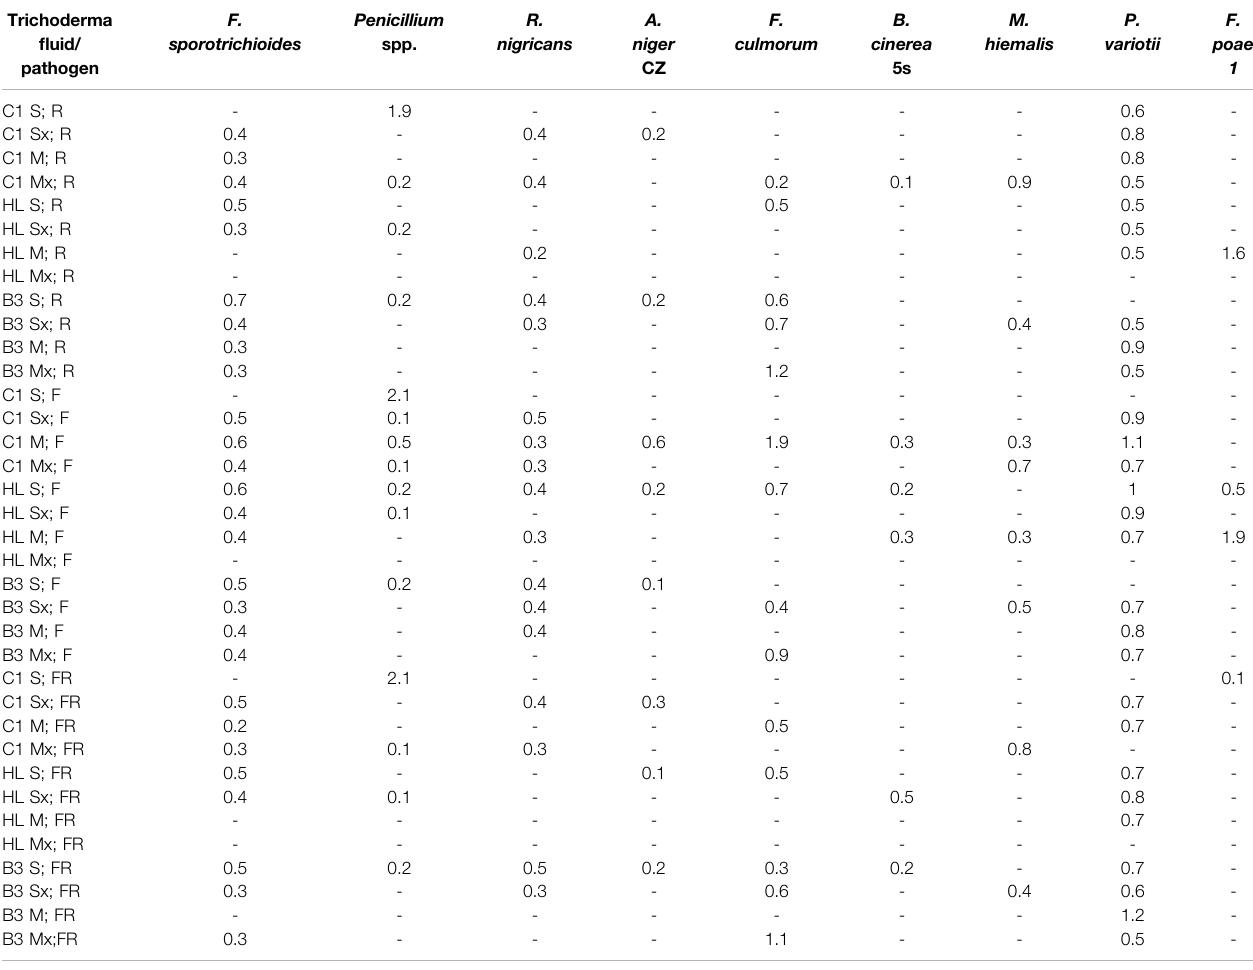
TABLE2| Theclearzones(cm)aroundthewells,raw fl uid(R),foam(F),andresidueafterfoaming(FR)."-" — noinhibition,(M)MGPmedium,(S)Saundersmedium,(Mx)MGP medium with inducers, (Sx) Saunders medium with inducers. E. nigrum and L. lecanii did not produce inhibition zones. Trichoderma fl uid/ pathogen